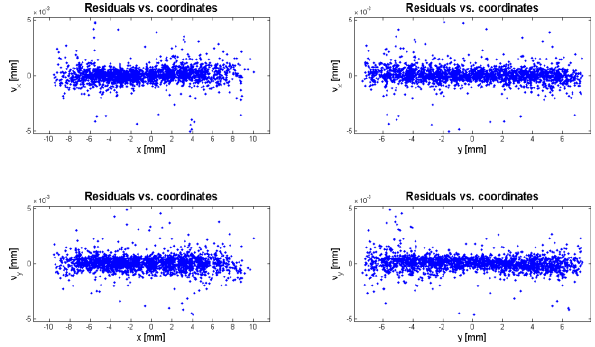
Figure 10. Plots of residuals vs. image coordinates after removing the radial and “local” lens distortion for the 24 mm lens calibration of the Canon T3